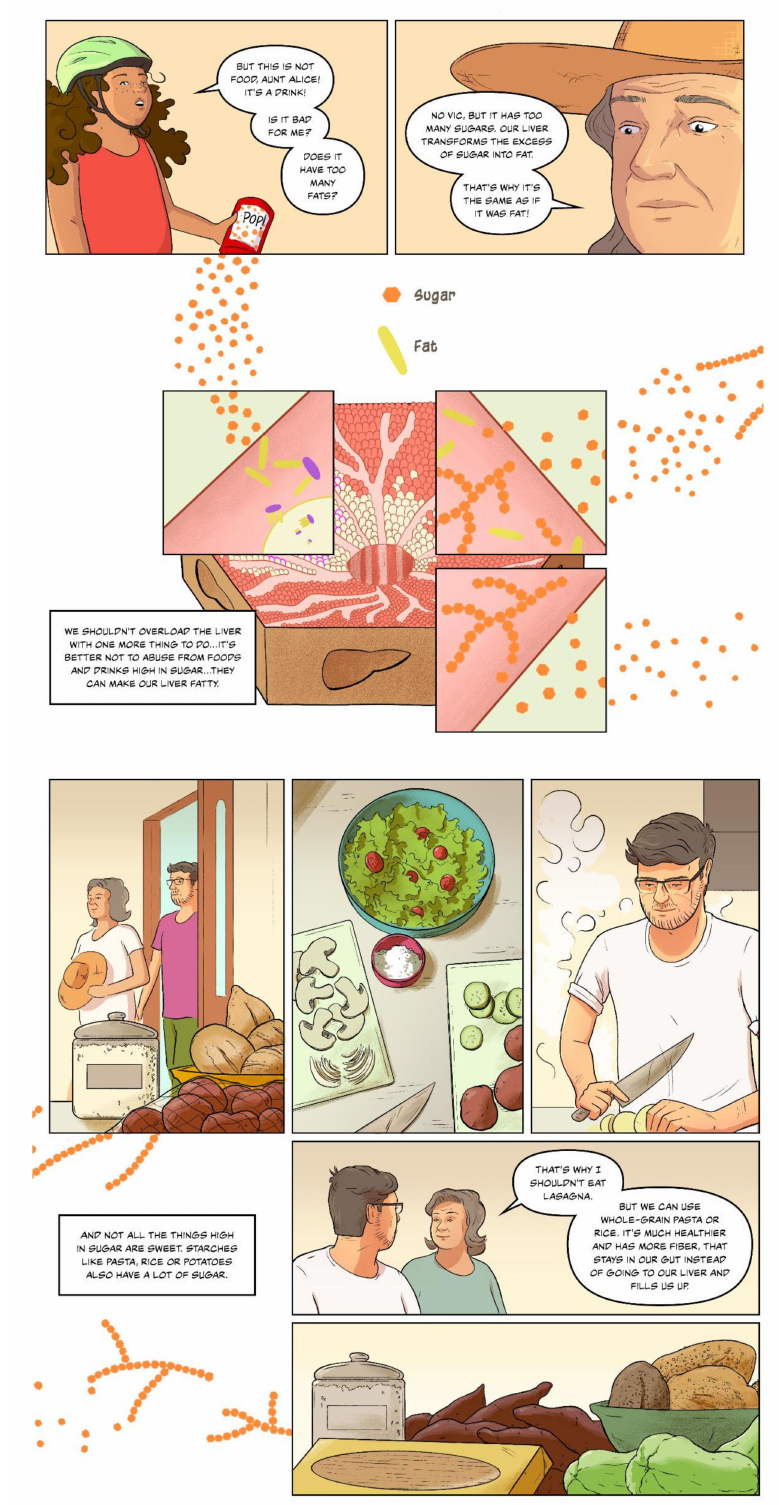
Figure 3. The use of characters with specific biographies and storylines to help convey both biochem- ical information (the synthesis of fat from sugars) and to help convey information relative to nutrition and healthier lifestyles (see text for